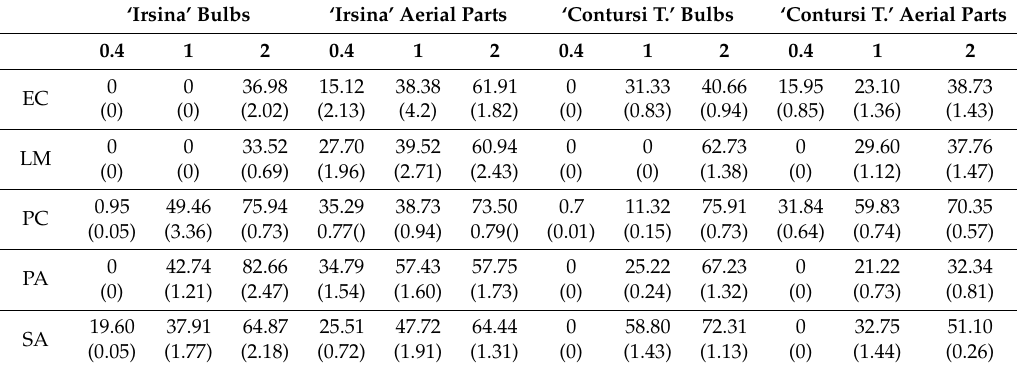
Table 6. Inhibitory activity exhibited by the di ff erent concentrations of the extracts of bulbs and aerial parts of ‘Irsina’ and ‘Contursi’ landraces on the bacterial metabolism within the 24-h preformed bacterial biofilms. The data are expressed as percentage respect to the control (assumed as 0%). Results are the mean of three experiments ( ± SD). EC: E. coli ; LM: L. monocytogenes ; PC: P. carotovorum ; PA: P. aeruginosa